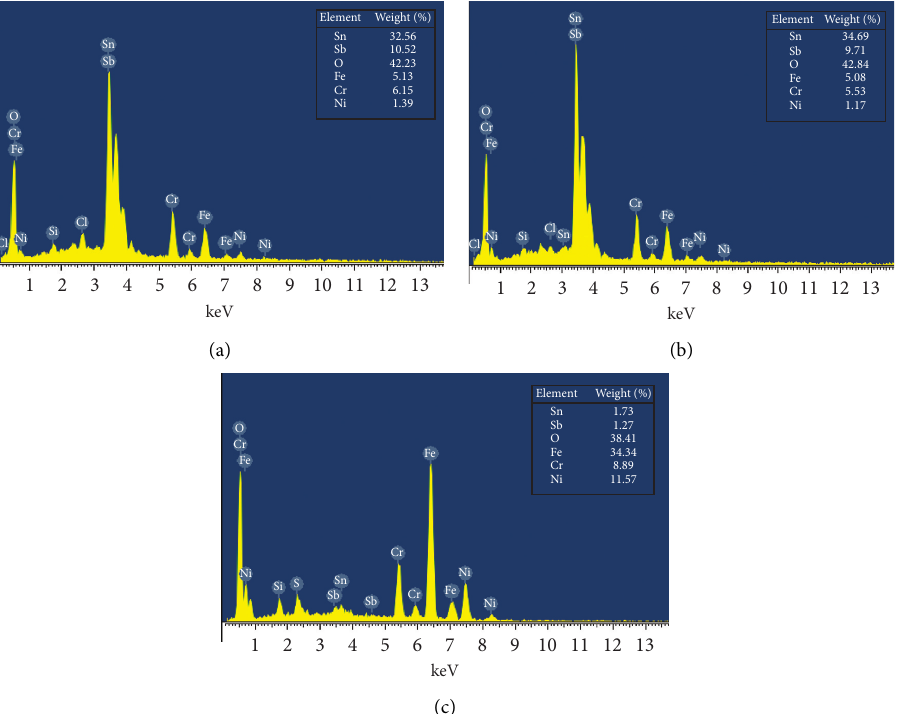
Figure 2: EDX patterns of Sb-doped SnO 600 ° C.